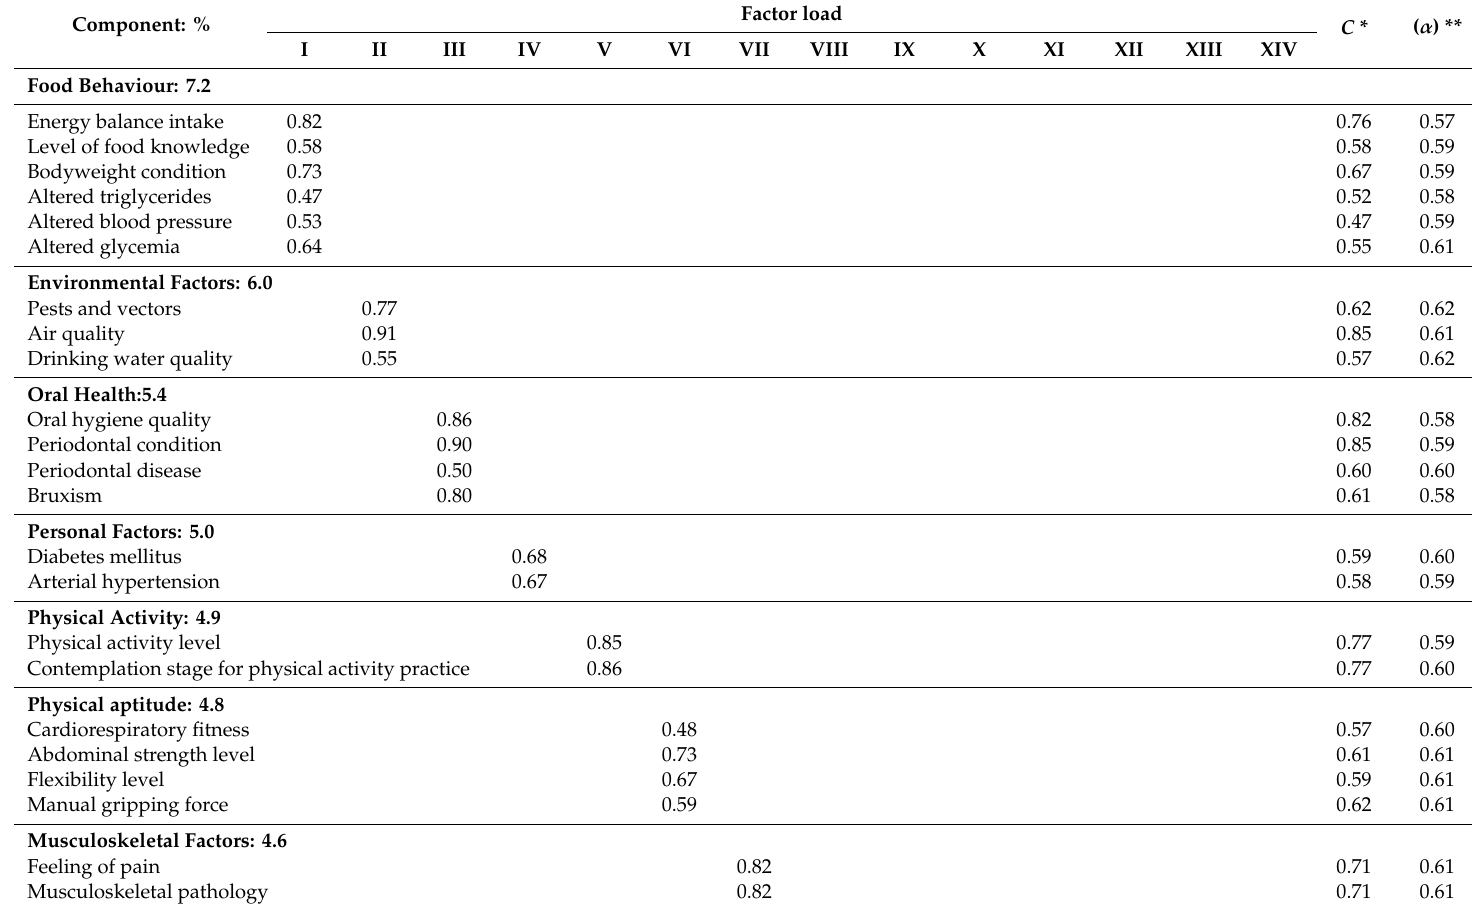
Table 6. Factor load and communality of the indicators under